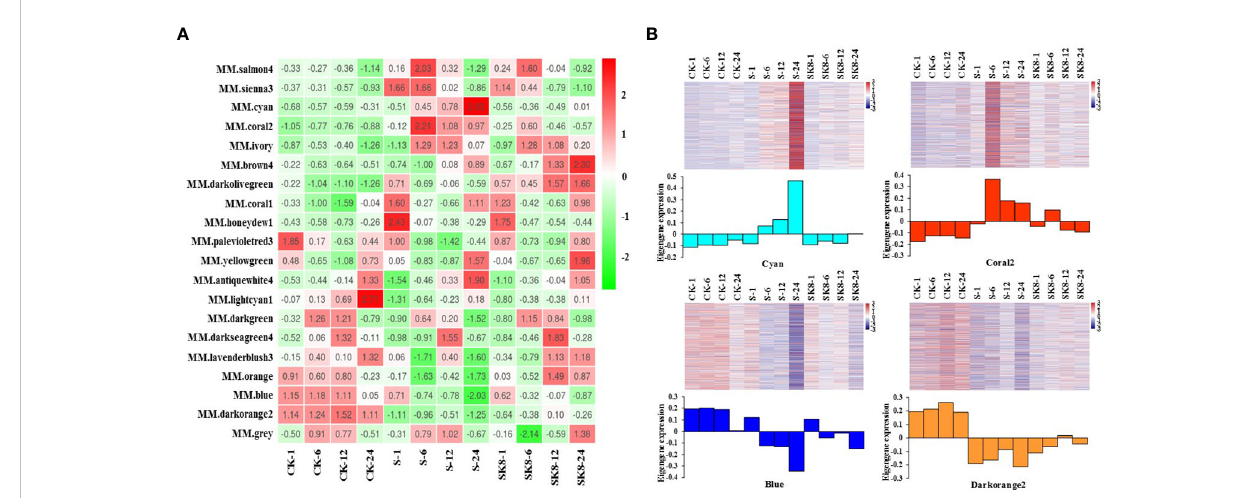
FIGURE 4 Sample expression heatmap of co-expression modules. (A) , the color in the heatmap indicates the characteristic value of the module, red represents high expression, and green represents low expression; (B) , the above fi gure is the expression heatmap of genes in the module in different samples, and the fi gure below shows the eigenvalues of modules in different samples, red indicates upregulation and blue indicates